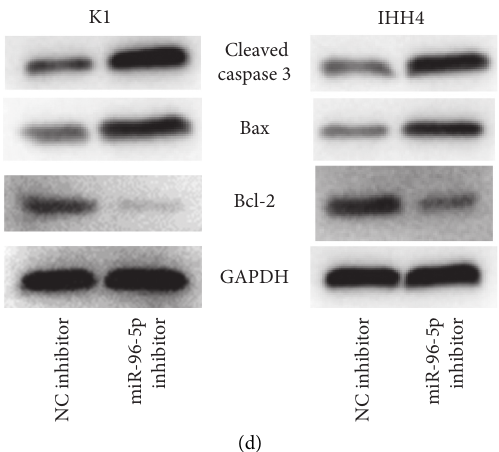
Figure 4: miR-96-5p downregulation suppresses PTC cell proliferation and promotes apoptosis. Note. (a) MTT assay was conducted to separately detect the optical density values at 490nm at 24, 48, and 72h in K1 and IHH4 cells after downregulating miR-96-5p; (b) cell proliferation was examined in K1 and IHH4 cells after miR-96-5p downregulation by EdU assay; (c) Flow cytometry was used to analyze the scatter patterns of cell cycle distribution of K1 and IHH4 cells after downregulating miR-96-5p; (d) the protein bands of apoptosis-related proteins in K1 and IHH4 cells after downregulating miR-96-5p were detected by western blot. ∗∗ P < 0 .